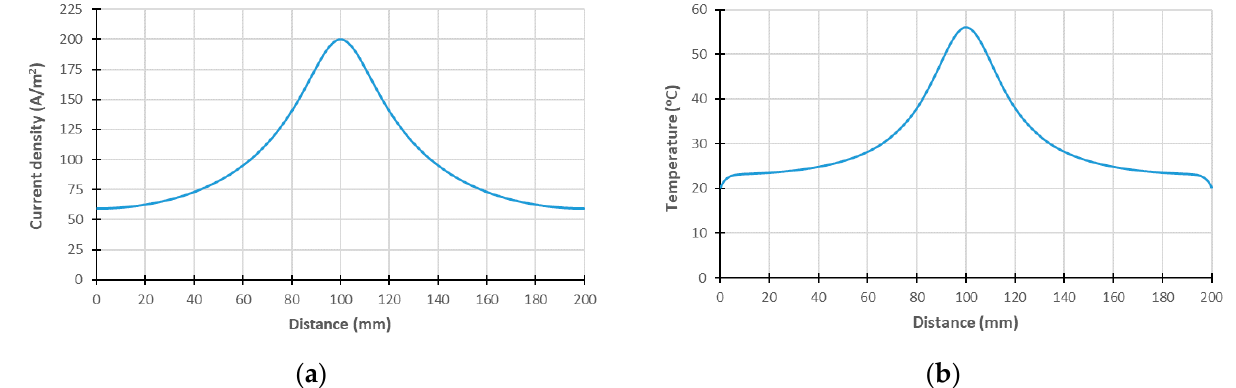
Figure 7. Results obtained along the axial distance of the model for a volume conductivity of 1 mS/m and an external temperature of 20 °C with ( a ) the current density distribution and ( b ) the surface temperature distribution.